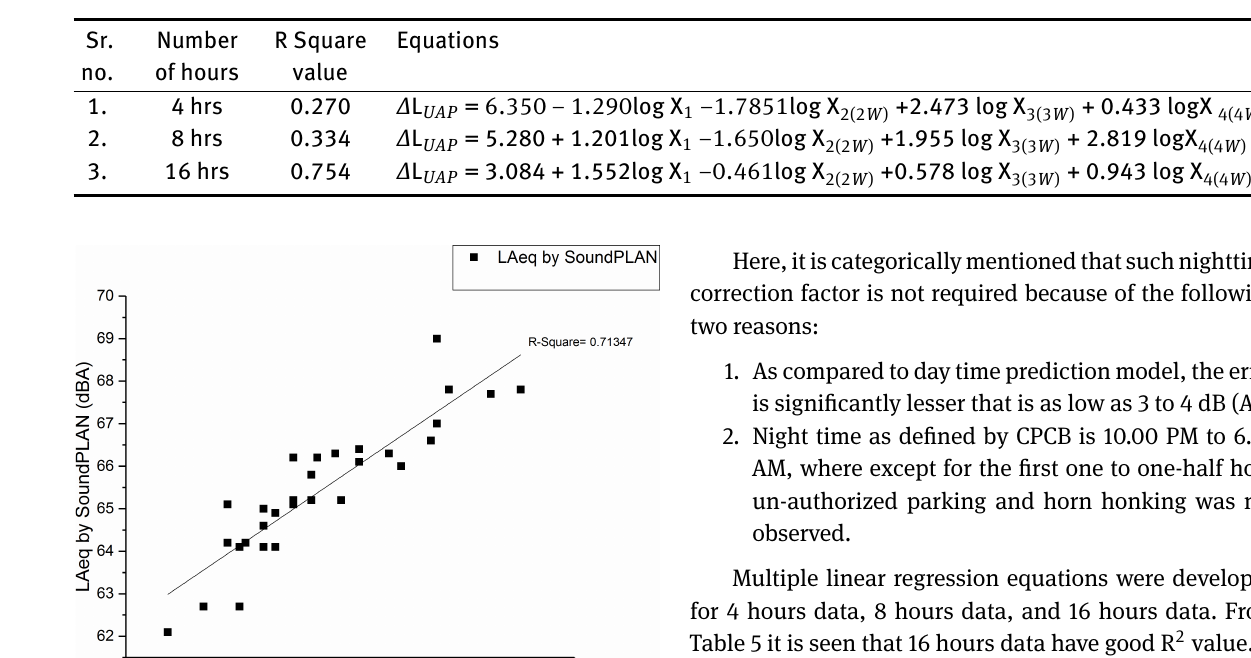
Figure 11: Measured L Aeq vs L Aeq − SoundPLAN without horn correction